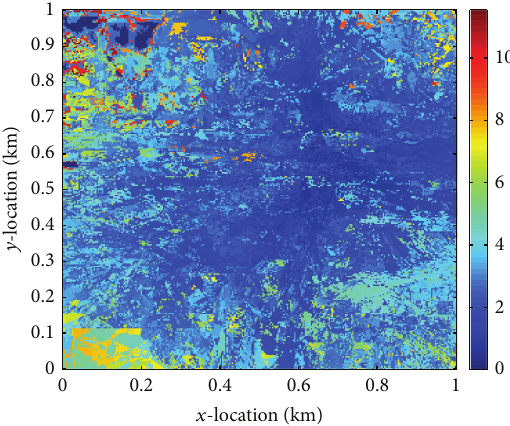
Figure 5: Simulated TOA ( 𝜇 s) data from the MCD for downtown State College, PA, for Scenario B. Data plotted for the dominant multipath.